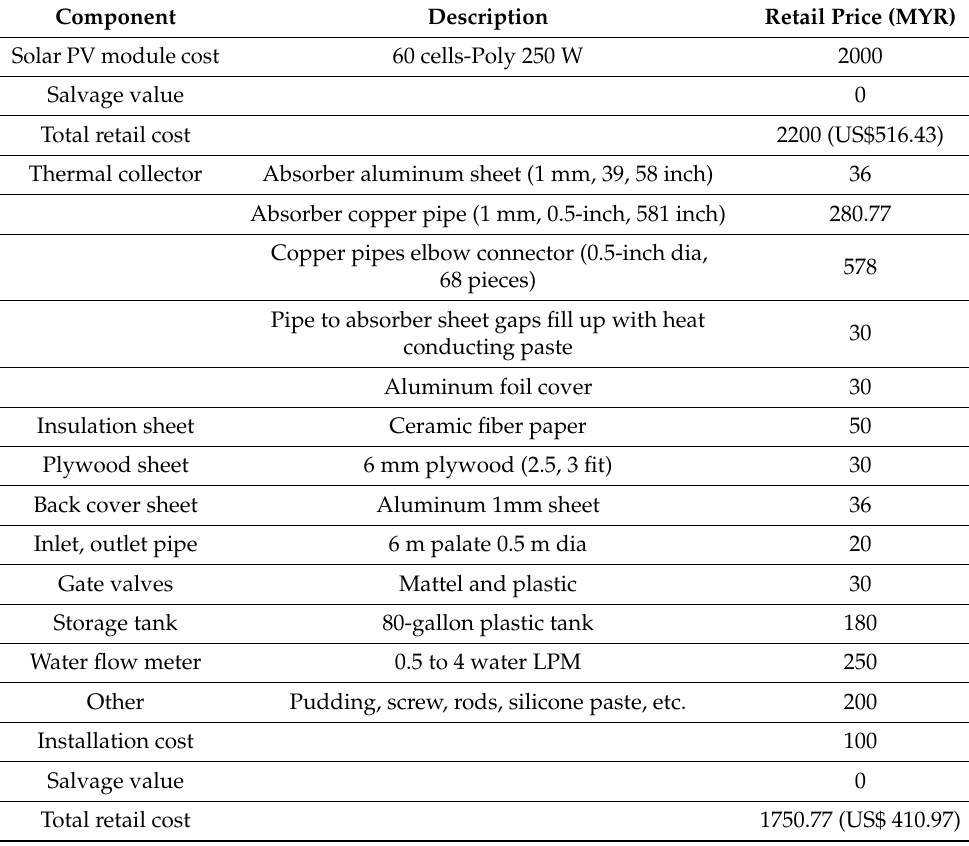
Table A1. The breakdown cost of solar PV module and thermal collector (PVT system).